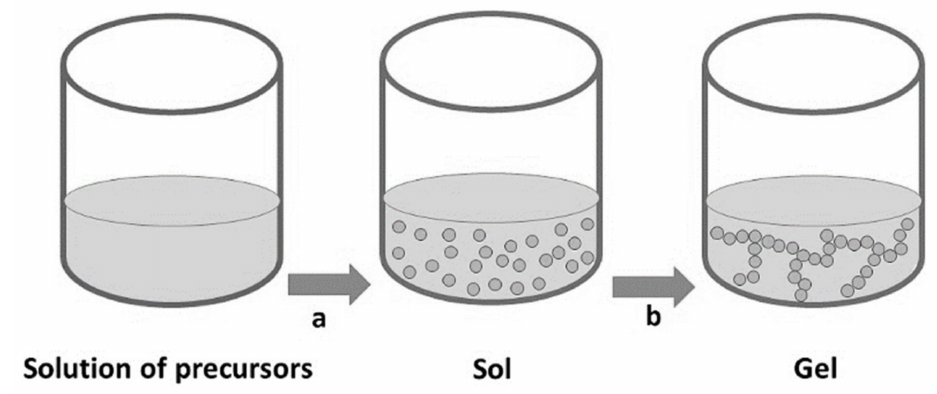
Figure 11. The condensation of precursor and gelation step